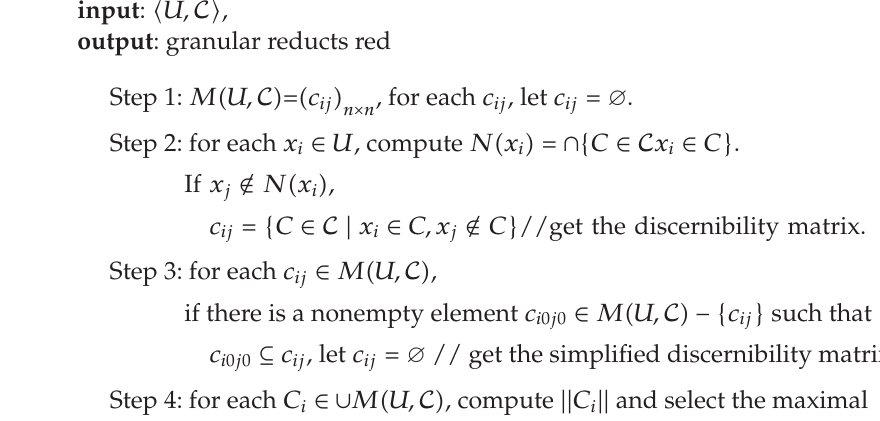
Algorithm 4.7. Consider the following: